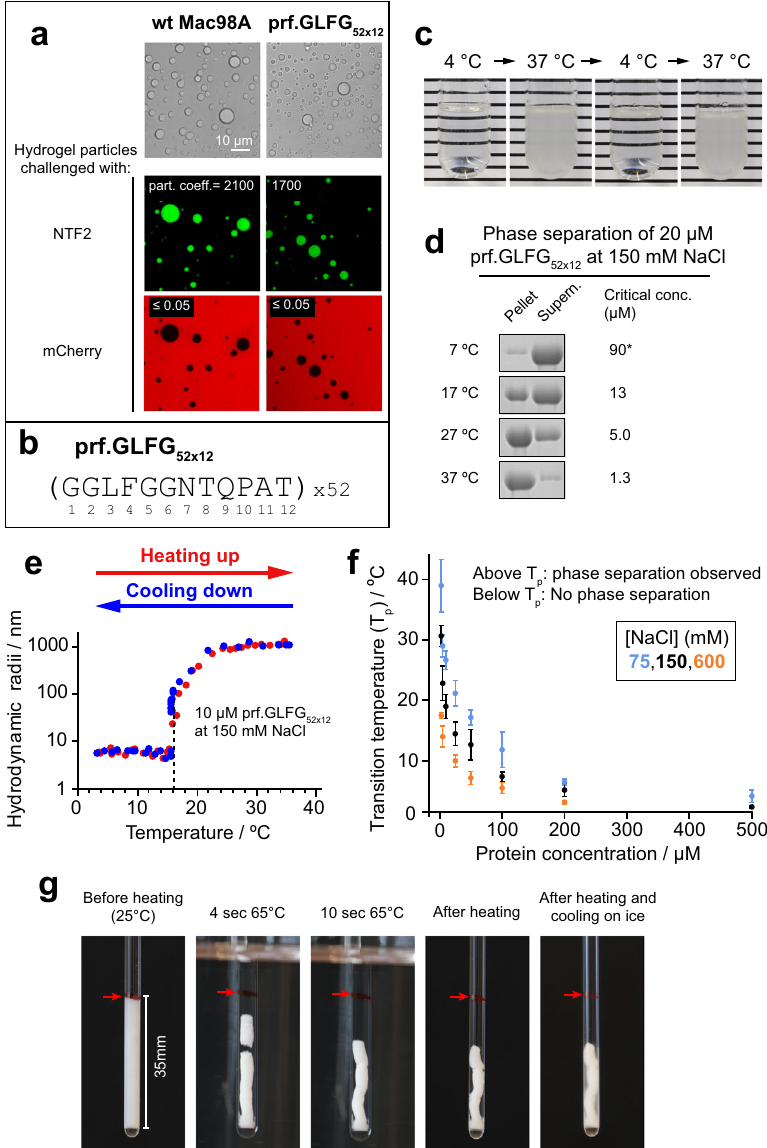
Fig. 1 Phase separation of Nup98 FG domains shows a lower critical solution temperature (LCST) behaviour. a Both the wild-type Mac98A FG domain and an engineered perfectly repetitive sequence, prf.GLFG 52×12 , phase separate to near-spherical particles following puri fi cation and dilution out of 2 M guanidine hydrochloride with an aqueous buffer (Methods), as shown by microscopy (top: phase-contrast microscopy images, below: confocal laser scanning microscopy images). Both FG phases exhibit NPC-like transport selectivity: they allow the partition of a nuclear transport receptor NTF2 (labelled with Alexa Fluor 488, green) to a partition coef fi cient of ~2000, but exclude the inert probe mCherry protein (partition coef fi cient < 0.05) (red). b Sequence of prf.GLFG 52×12 containing 52 perfect repeats of a 12-mer peptide. c A dilution of prf.GLFG 52×12 (15 μ M at 400 mM NaCl) at 4 °C does not display phase separation, however when warmed up to 37 °C, it turns turbid readily, indicating phase separation. The process is reversible by cooling back to 4 °C. d 20 μ M dilutions of prf.GLFG 52×12 prepared at room temperature and centrifuged at different temperatures. SDS samples of the obtained pellets (FG phase) and supernatants (aqueous phase) are shown on SDS-PAGE, followed by Coomassie blue staining. Critical concentrations for individual conditions are taken as the concentrations of the supernatants. Full scans of gels with molecular weight markers are provided in the Source Data fi le. *At 7 °C, 100 μ M of prf.GLFG 52×12 is required to determine the critical concentration. e A dilution of prf.GLFG 52×12 analysed by Dynamic Light Scattering (DLS), with the temperature increased from 2 to 40 °C (red). A sharp increase in hydrodynamic radii (from ~5 nm, expected for monomers 26,34 , to fi nal radii of ~1000 nm, expected for the multimeric FG particles) indicates phase separation at a transition temperature ( T p ) ~16 °C. As in c , the phase separation is reversible by cooling (blue). f DLS analysis repeated with different concentrations of prf.GLFG 52×12 and NaCl to determine T p , which is plotted against prf.GLFG 52×12 concentration. Data are plotted as mean values ± standard deviations (S.D.s) of three replicates. g Photographs of 30 mg of phase- separated prf.GLFG 52×12 after centrifugation into a volume of ~150 μ l at 25 °C, heated to 65 °C for 1 min, then cooled down on ice for 15 min. The red arrow marks the boundary between the condensed and the aqueous phase before